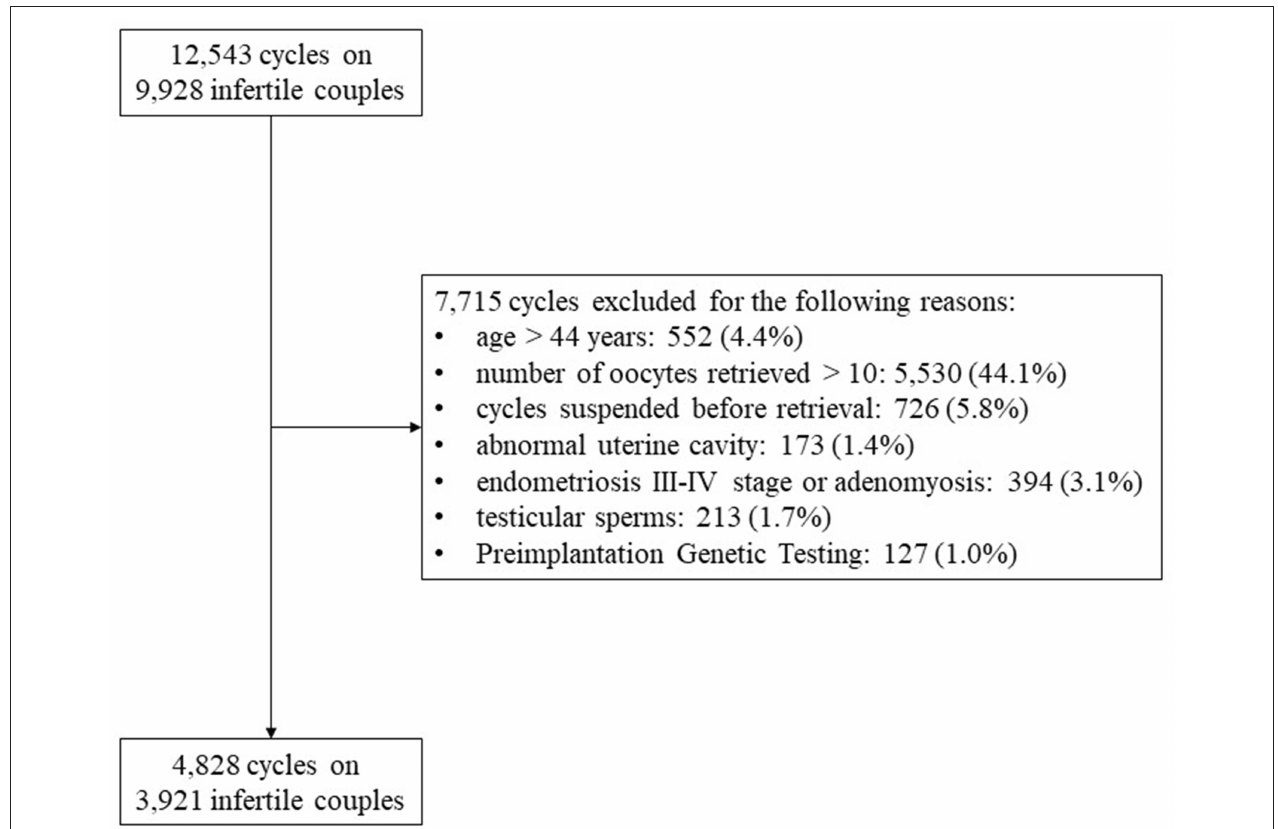
FIGURE 1 | Study flow chart. * p <